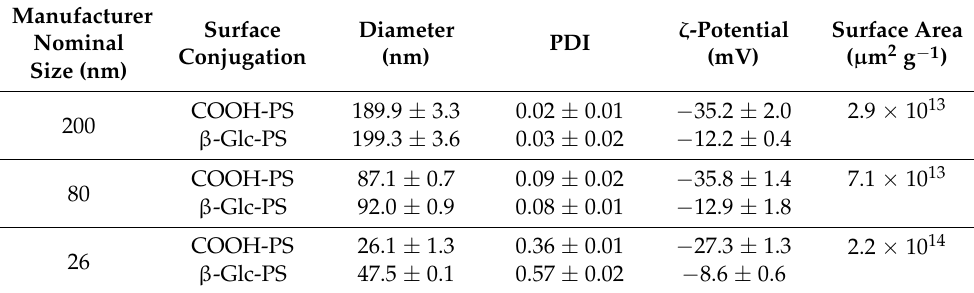
Table 3. Physical properties of polystyrene NP before (COOH-PS) and after conjugation with ( β 1,3)- glucans ( β -Glc-PS). The average hydrodynamic size of COOH-PS and β -Glc-PS NP was evaluated through dynamic light scattering (DLS) at a concentration of 0.5 mg mL − 1 . PDI values were determined by DLS using DynaPro Plate Reader II. Zeta-potential analysis of COOH-PS and β -Glc-PS was performed using Malvern Zetasizer Nano ZS particle analyser. Surface area valeues were obtained from manufacturer. Values represent mean ± SD from three independent experiments.